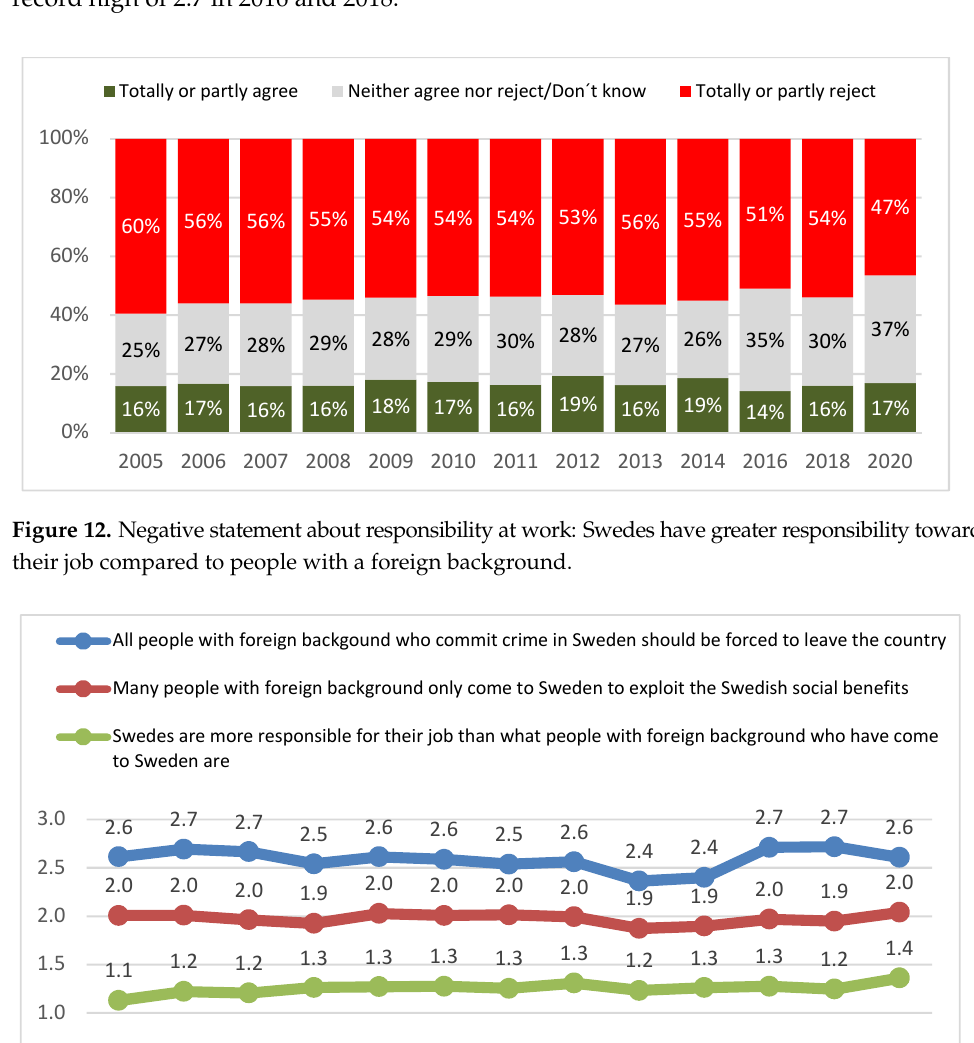
Figure 12. Negative statement about responsibility at work: Swedes have greater responsibility towards their job compared to people with a foreign background.